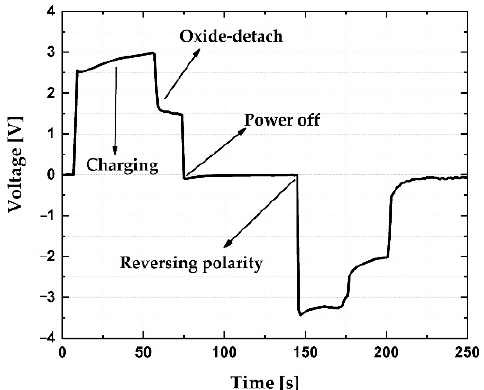
Figure 7. Time dependence of voltage during the electrode activation process.